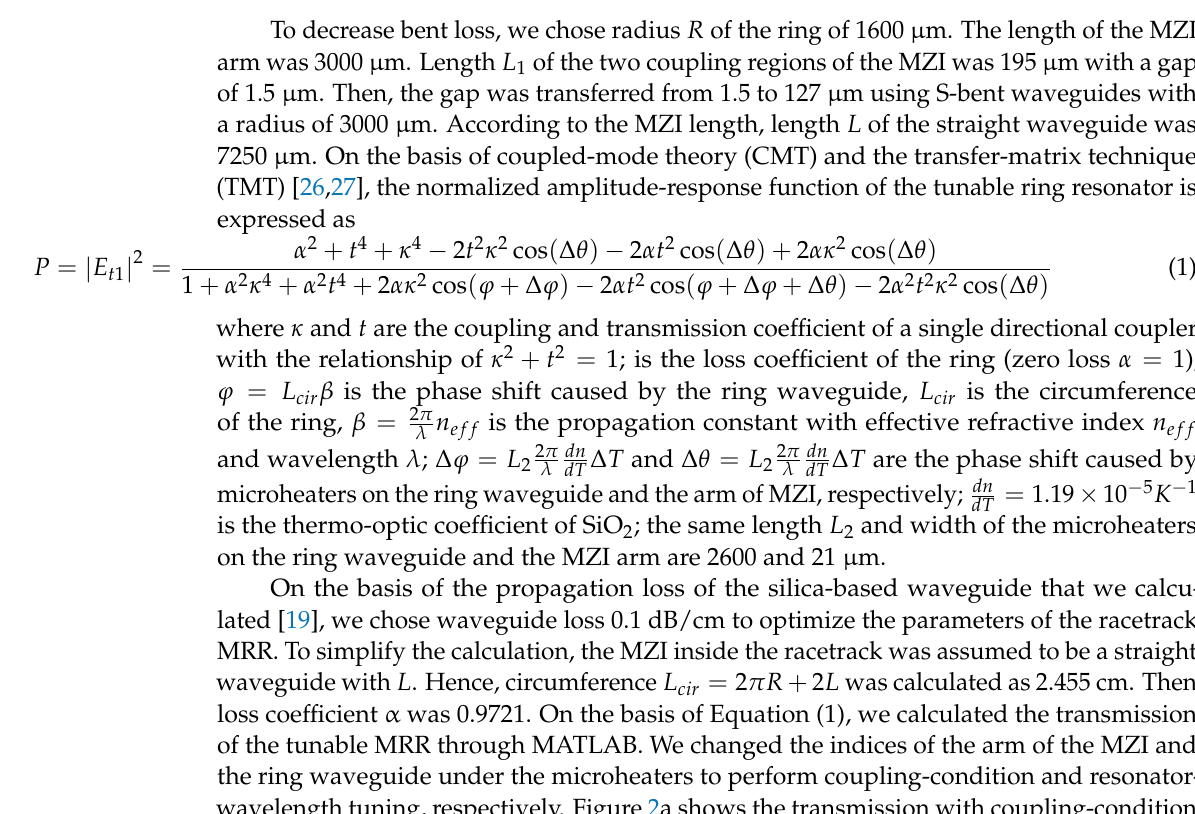
Figure 1. Structure of tunable microring resonator.